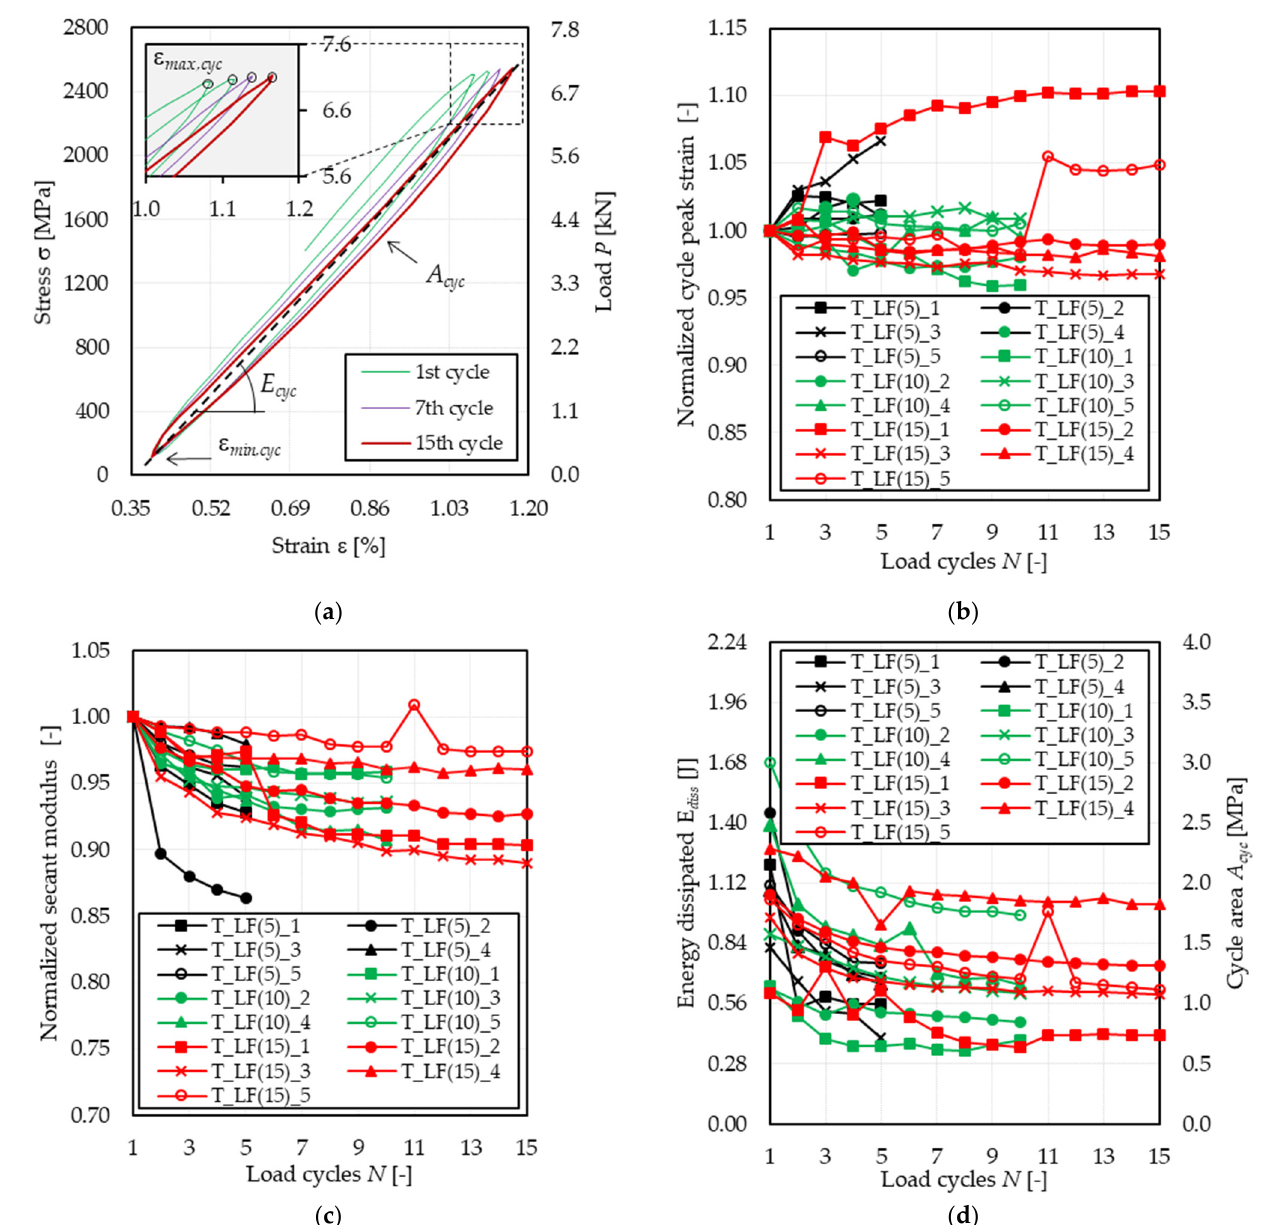
Figure 6. Effect of low-cycle fatigue on the tensile response of tested specimens. ( a ) Stress (load)–strain response of specimen T_LF(15)_3 during the cyclic phase. ( b ) Variation in the normalized cycle peak strain with the number of cycles. ( c ) Variation in the normalized secant modulus with the number of cycles. ( d ) Variation in the energy dissipated (cycle area) with the number of cycles.